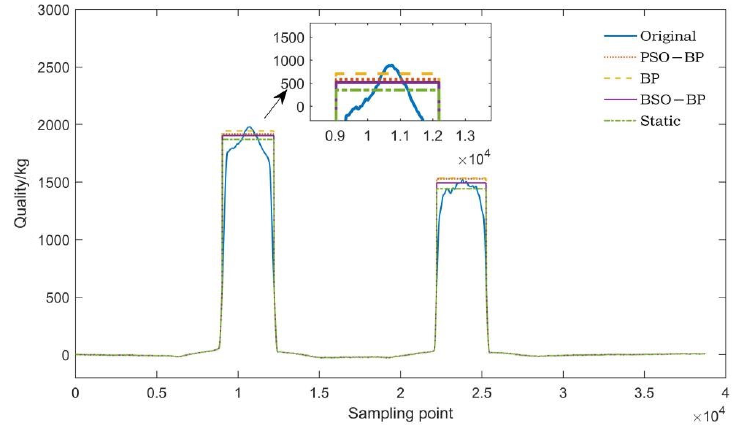
Figure 10. Corrected axle weight waveform comparison of a two-axle vehicle.